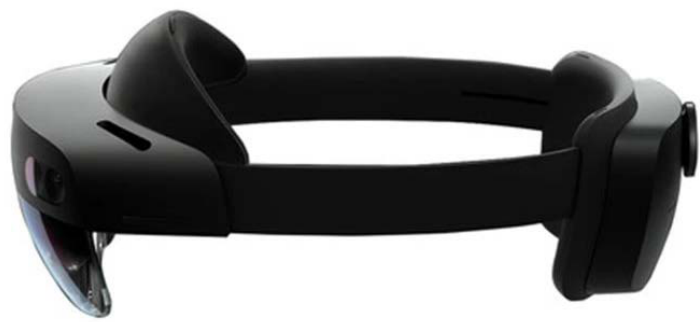
Figure 4. HoloLens 2 headset with the computing unit on the back.